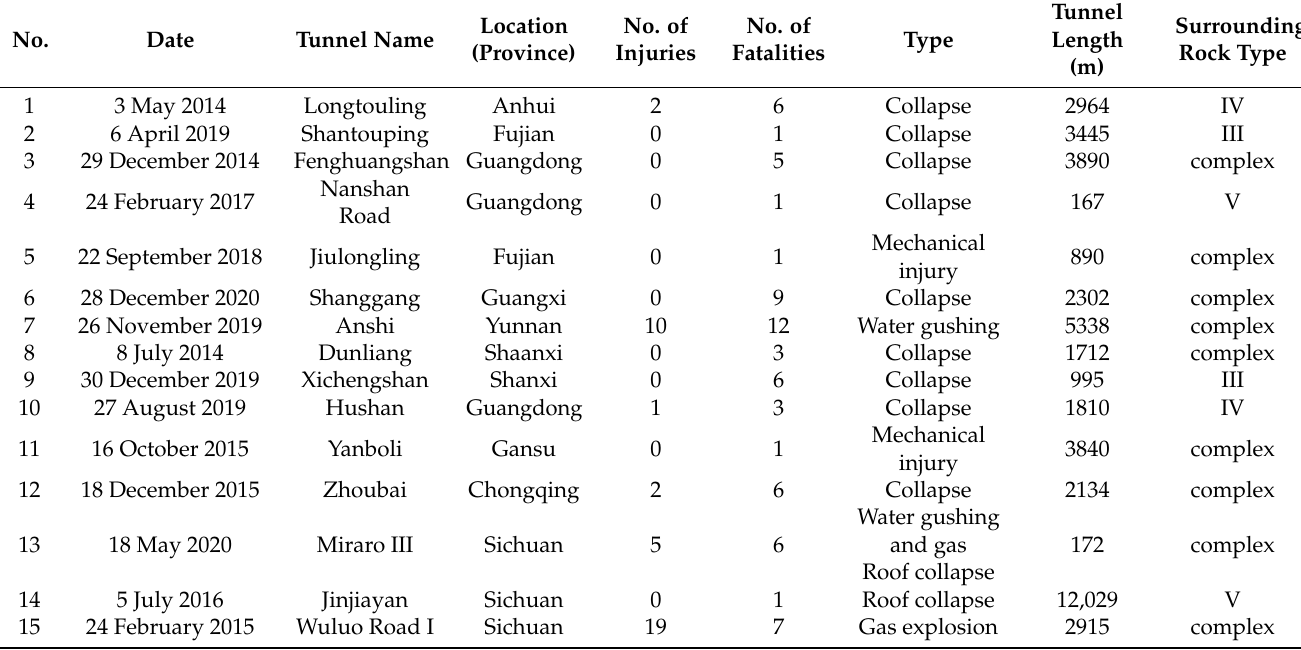
Table 1. Tunnel construction accident